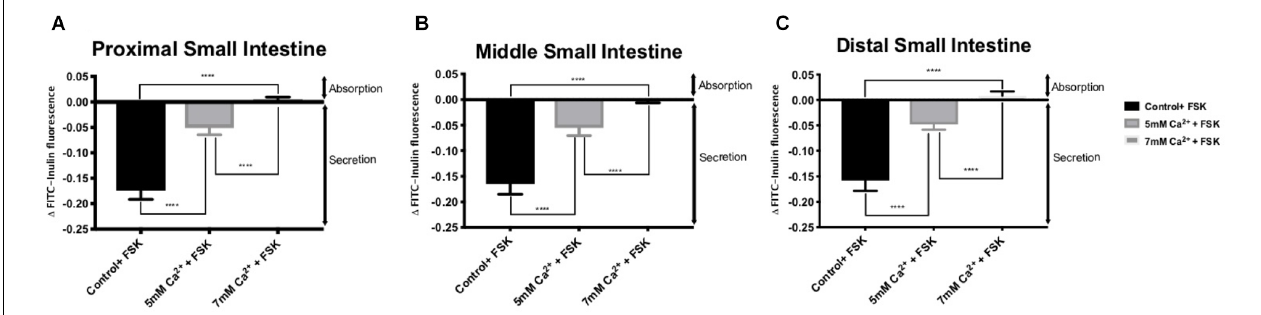
FIGURE 2 | Intestinal fluid secretion in the presence of intraluminal 10 µ M forskolin with varying [Ca 2 + ] in the: (A) Proximal small intestine (B) Middle small intestine (C) Distal small intestine. P value < 0.0001 is represented by ∗∗∗∗ .